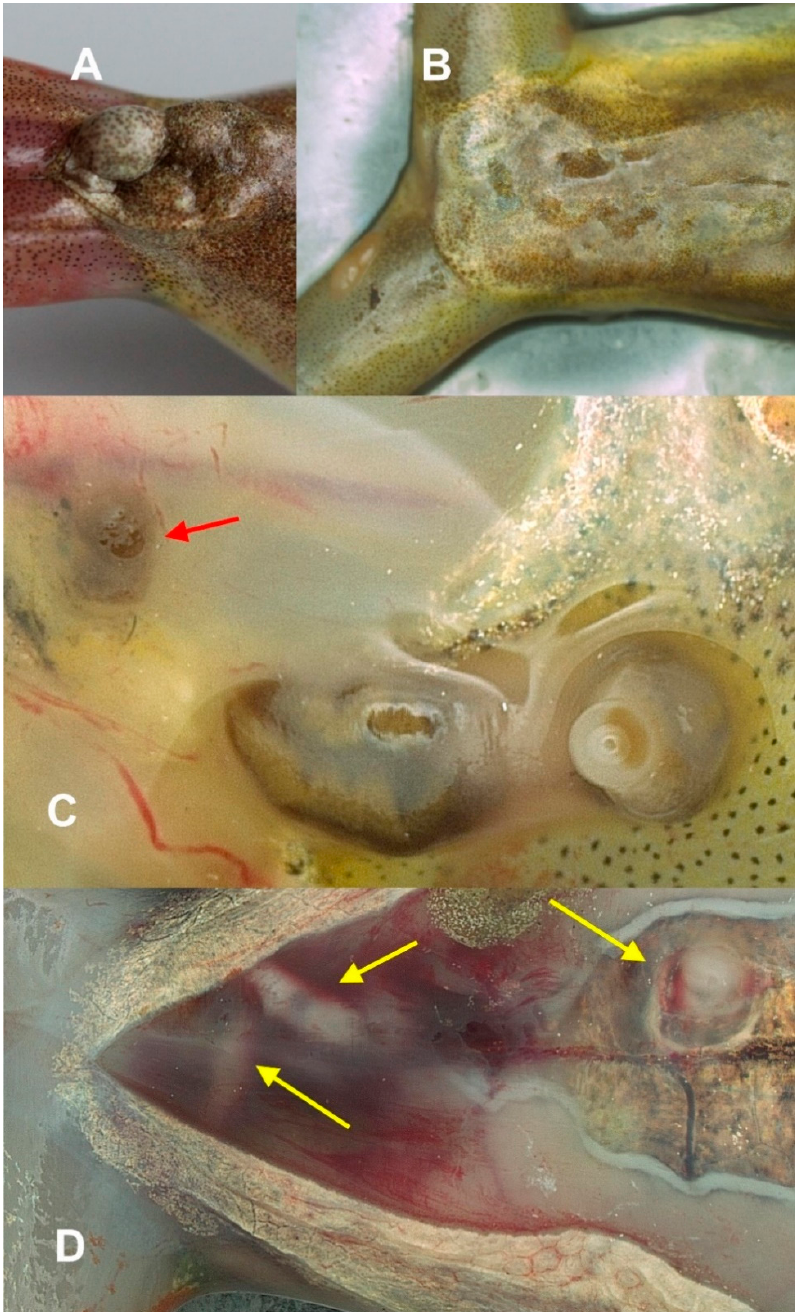
Figure 7. Intra-host migration of C. chabaudi metacercaria in a male H. viridiflavus , starting from cysts in the subdermal lymphatic sacs to the abdominal body cavity. ( A ) Metacercaria cysts at the urostyle (October 26, 2015). ( B ) Hatched metacercariae moving within the lymphatic sac (November 30, 2015). ( C ) Free moving metacercaria and its brown feces (red arrow) within the dorsal lymphatic sac. ( D ) Ventral view on abdominal peritoneum. Two metacercariae (left yellow arrows) move within the bleeding body cavity. A third metacercaria is hatching from a cyst within the peritoneum.